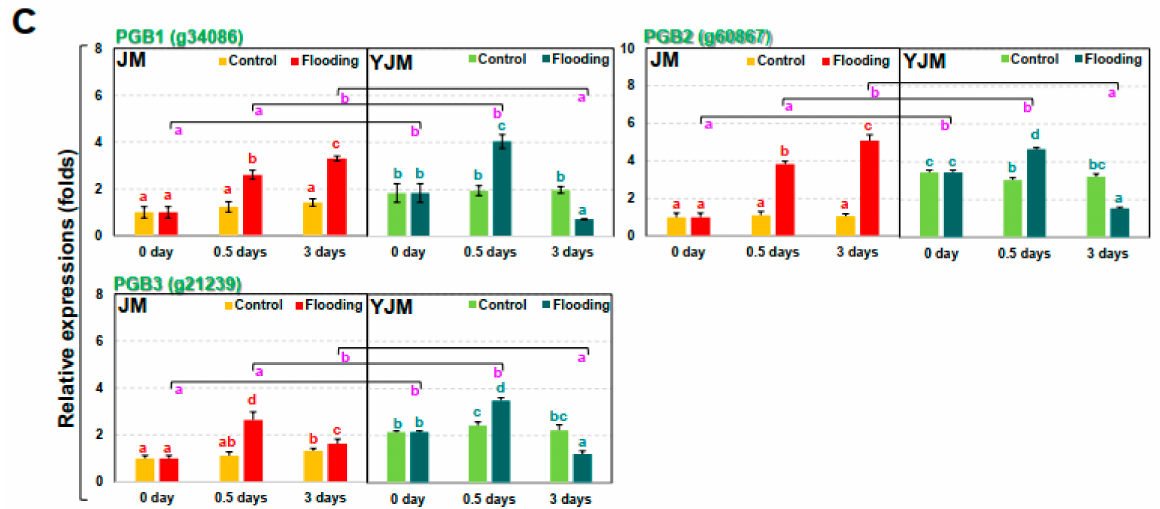
Figure 3. Levels of nitrite (NO 2 − ) and expression of NO-related genes in sweet potato cultivars treated with flooding stress for 3 d. ( A ) Relative levels of NO 2 − in each cultivar after 0, 0.5, or 3 d of flooding treatment. ( B ) Expression of the NO biosynthesis genes NR and NIR in each cultivar after 0, 0.5, or 3 d of flooding treatment. ( C ) Expression of PGB genes in each cultivar after 0, 0.5, or 3 d of flooding treatment. Different letters represent statistically significant differences between control and flooding treatment, and between flooding-treated JM and YJM, determined using two-way ANOVA with the LSD post hoc test; p <